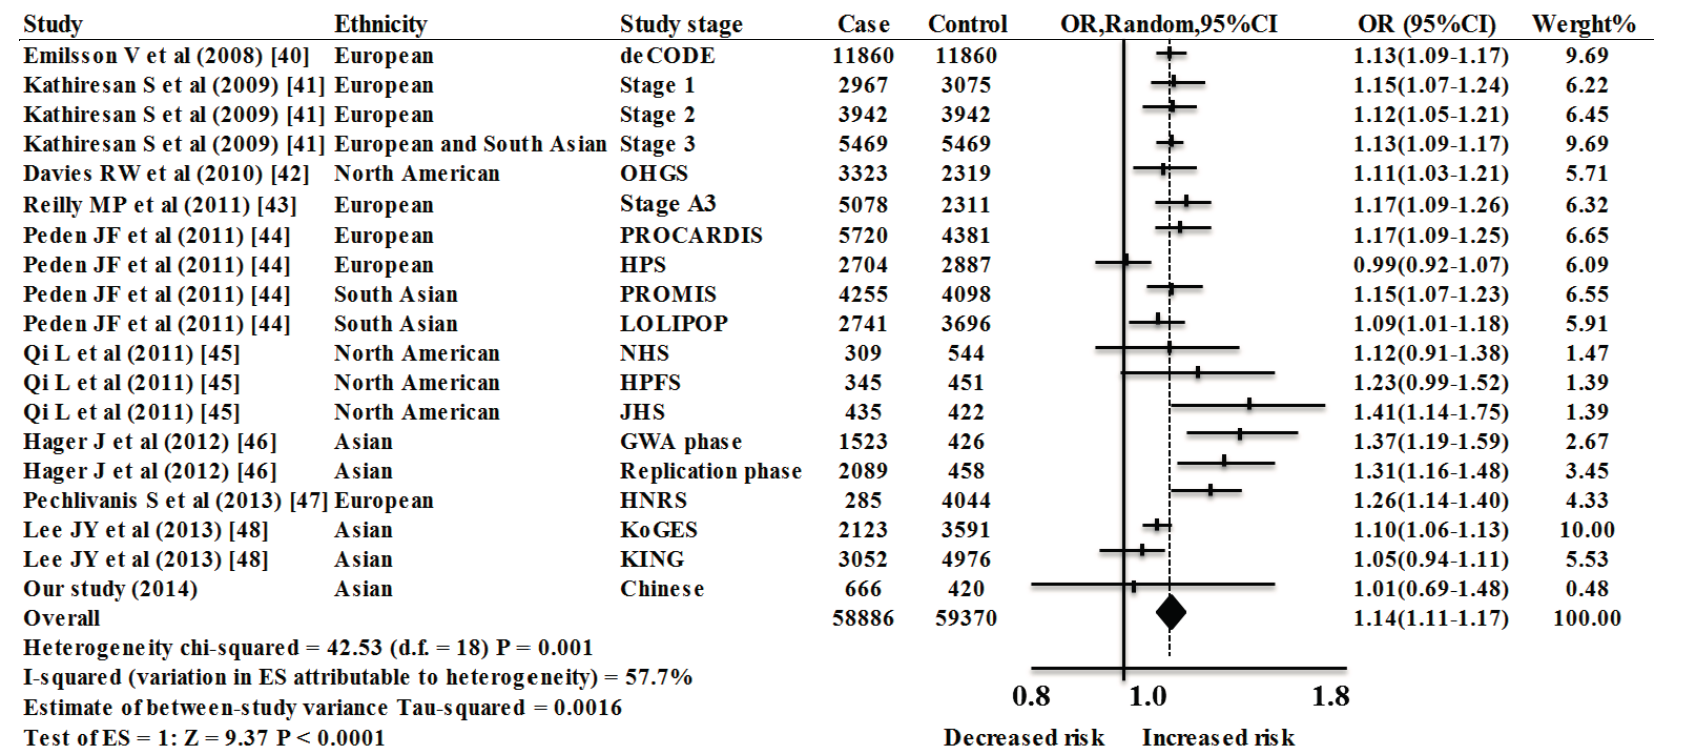
Figure 2. Meta-analysis of 19 association studies between rs12526453 and risk of CAD. Stage 1: MIGen (Myocardial Infarction Genetics Consortium); Stage 2: WTCCC (Wellcome Trust Case Control Consortium), GerMIFSI (German MI Family Study I), PennCATH (PennCATH), Medstar (MedSTAR); Stage 3: AMI Gene (Acute Myocardial Infarction Gene Study/Dortmund Health Study), Verona (Verona Heart